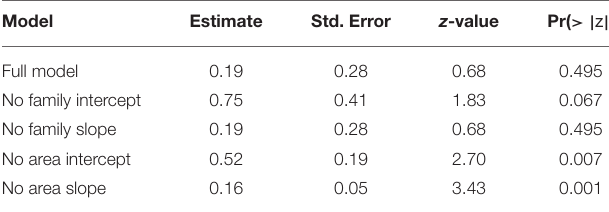
TABLE 3 | How the estimate for the coefficient for the effect of humidity on the number of tones changes when altering the random effects structure ( lme4 model with PHOIBLE